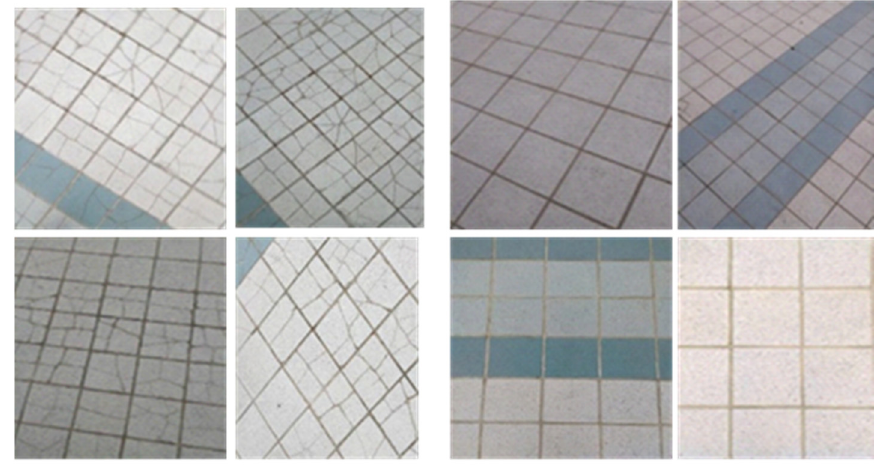
Figure 5. Left , Tile Sample with Crack; Right , Tile Sample without Crack.